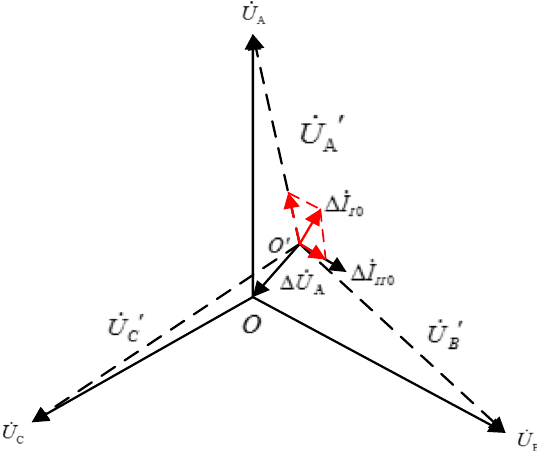
Fig. 5 Phasor-diagram of the system under HIFs